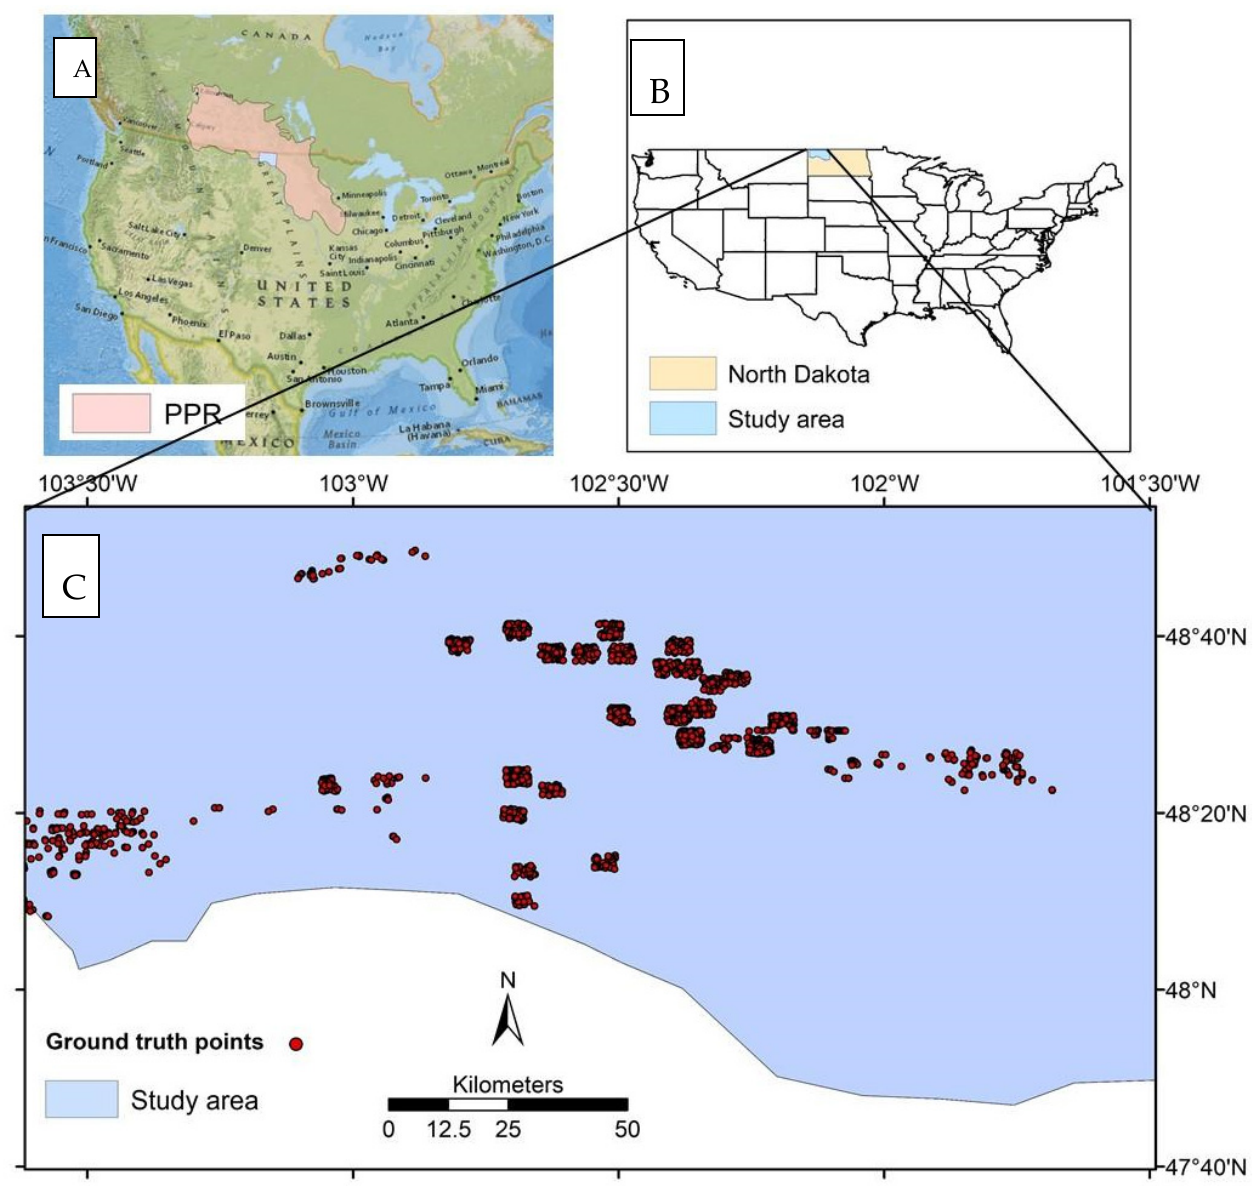
Figure 1. The location of the Prairie Pothole Region (PPR) ( A ); the location of the study site in the US and the state of North Dakota ( B ); distribution of ground truth points in the study site ( C ).